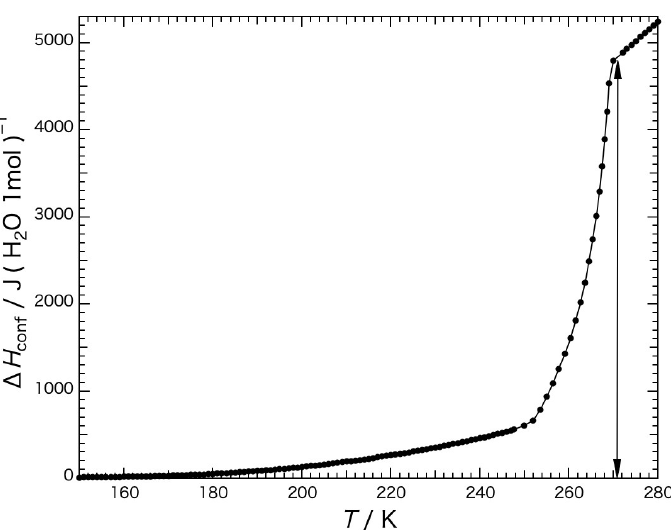
Figure 6. Temperature dependence of the configurational enthalpy of the water within the Sephadex ® G25 gel ( h = 1.00) precooled slowly.